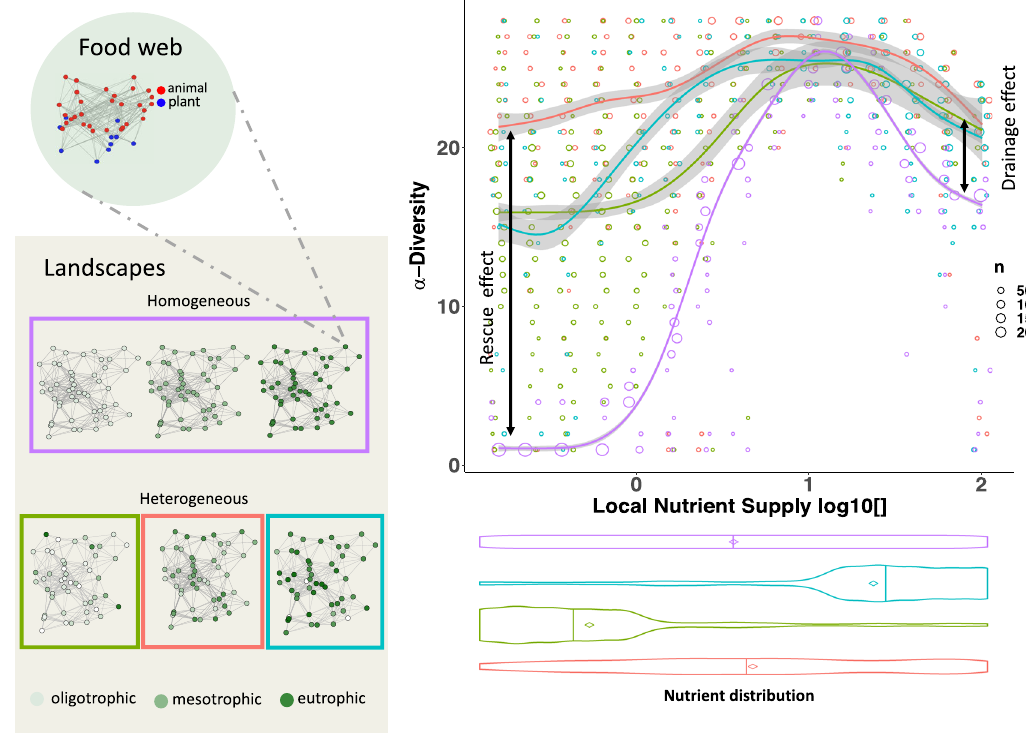
Fig. 4 Landscape heterogeneity drives biodiversity in complex meta-food-webs. Local diversity on a patch ( y -axis) across a gradient of local patch nutrient supply concentration (nodes in shades of green) in homogeneous (purple) and heterogeneous (green, orange, blue) landscapes. Violin plots below the x -axis show nutrient distributions within the landscape for each scenario, bars represent medians and diamonds represent means. The meta-food-web consists of a complex food web of 10 plants (blue nodes) and 30 animals (red nodes) and large homogeneous and heterogeneous landscapes with 50 habitat patches with different patch nutrient supply concentrations (nutrient supply concentrations on habitat patches are colour coded). Edges indicate dispersal links for an exemplary species with a dispersal range of 0.3. Lines are a smooth fi t from a GAM model with 95% con fi dence intervals in ggplot2, circles represent the data and the circle size the number of data